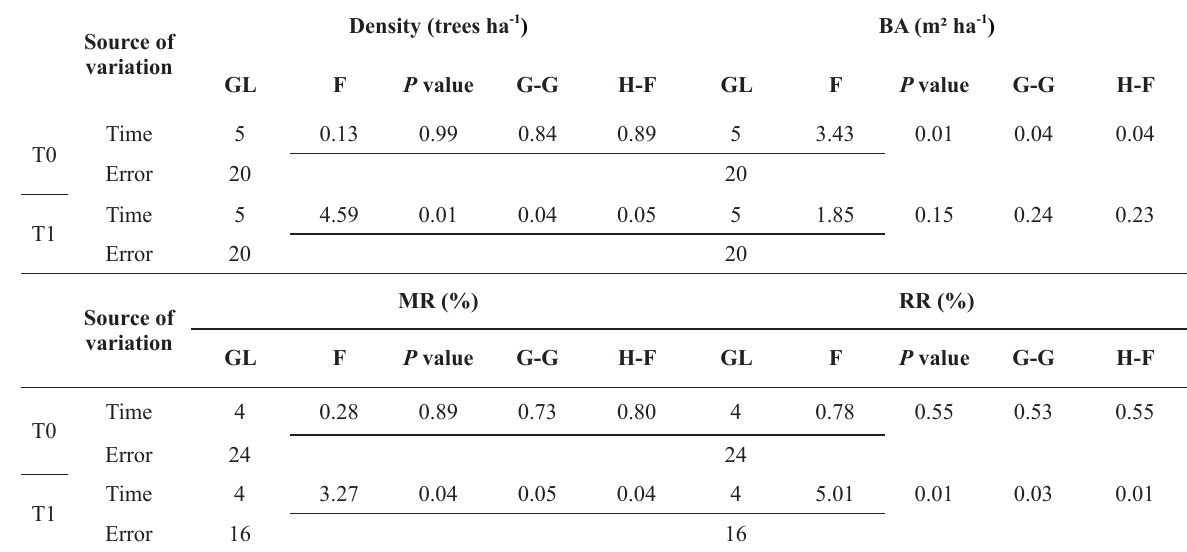
Analysis of Variance (ANOVA) of repeated measurements of historical records (1983-2012) of density (trees ha -1 ), basal area (m² ha -1 ), mortality rate (% year -1 ) and recruitment rate (% year -1 ) in T0 (no fire) and T1 (affected by fire, in 1997) plots, in an dense ombrophylous forest, with no history of logging, in the Floresta Nacional do Tapajós, Pará State, Brazil.